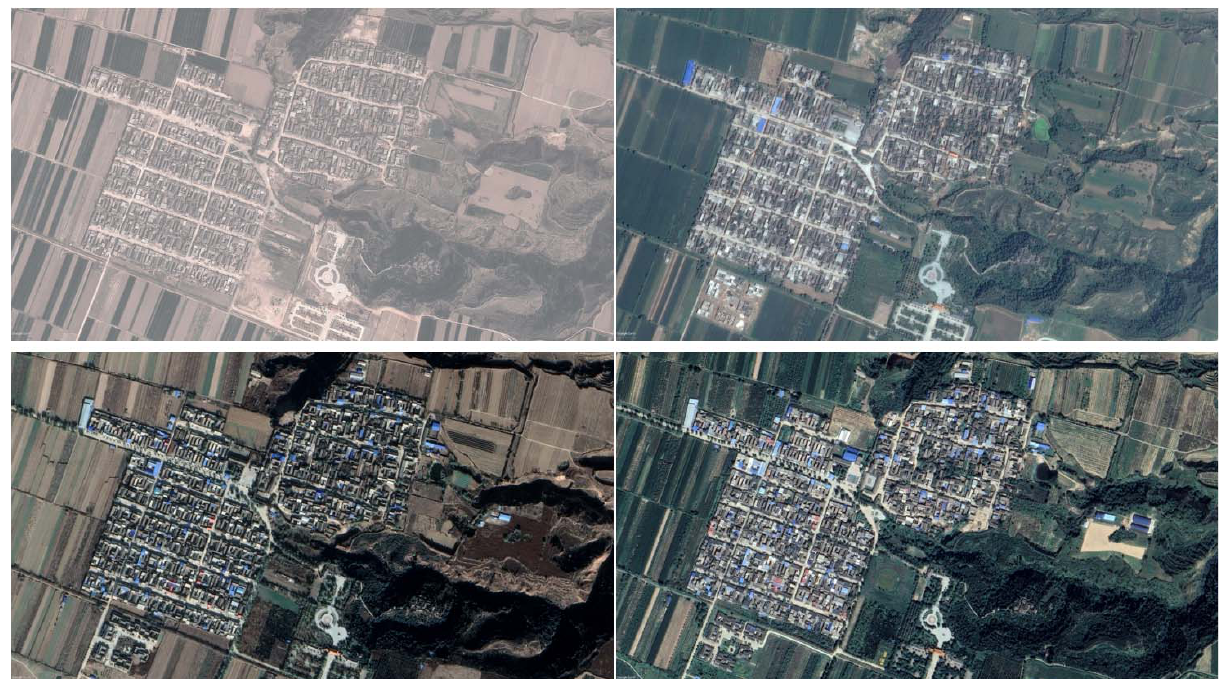
Figure 2. Remote sensing images of Lingquan village taken in years under study. From left to right and from top to bottom are the images for 2011, 2013, 2018, and 2020. (Source: Google Earth).